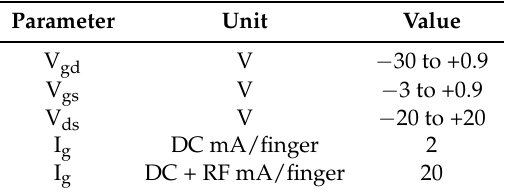
Figure 10. Simulated instant values of V GS , V DS , V GD , and I G versus time for every stage of designed LNA corresponding to an available source power between − 10 and − 3 dBm. Black dashed lines represent the limits reported in Table 4. Table 4. D01GH breakdown currents and